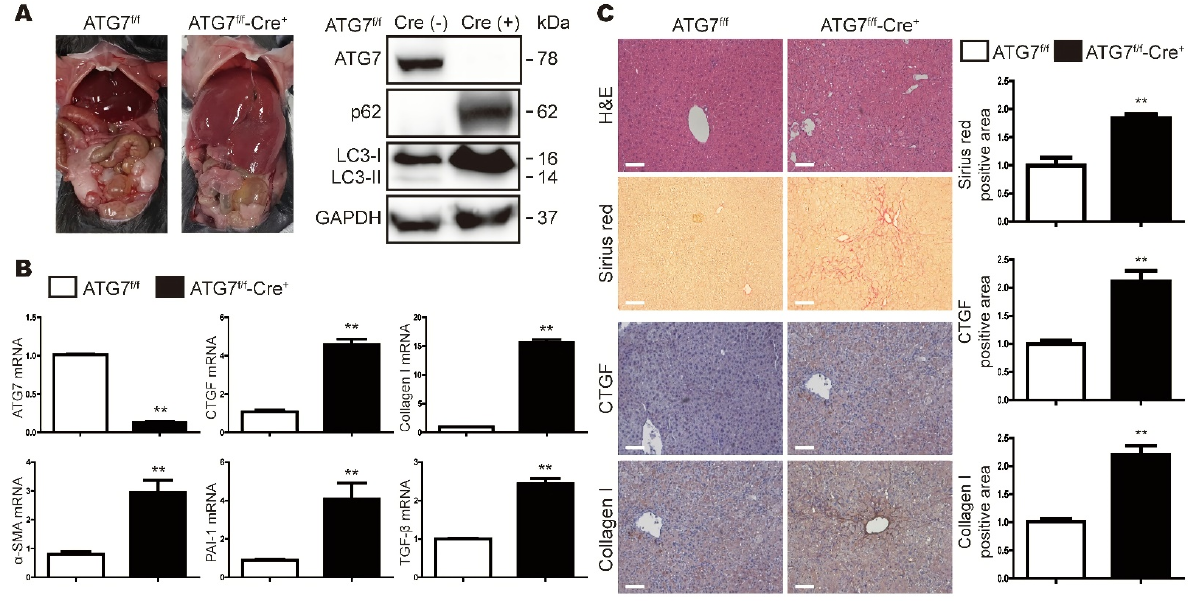
Figure 1. Loss of ATG7 in the mouse liver leads to fibrosis. ( A ) Gross anatomical views of the liver in representative 8-week-old male Cre-negative and Cre-positive ATG7 Flox/Flox (ATG7 f/f and ATG7 f/f -Cre + ) mice. Total liver lysates from ATG7 f/f and ATG7 f/f -Cre + mice were subjected to the Western blot analysis of ATG7, p62 and LC3. GAPDH expression was measured as a loading control. ( B ) Quantitative RT-PCR analyses of the indicated mRNAs in liver extracts from ATG7 f/f and ATG7 f/f -Cre + mice. The data represent the mean ± SEM (n = 8–10), and are normalized to the levels in ATG7 f/f mice. The data represent the mean ± SEM (n = at least 10 per group), and are normalized to the levels in ATG7 f/f mice. ** p < 0.01. ( C ) Hematoxylin and eosin (H&E), Sirius red, and immunohistochemical staining of liver tissue sections from ATG7 f/f and ATG7 f/f -Cre + mice. Each group contained 5–7 mice, and representative images are shown. The original magnification was ×100; the scale bars indicate 100 µm. The data in the graphs represent the mean ± SEM of five random fields per liver, and are normalized to the levels in ATG7 f/f mice; ** p < 0.01.